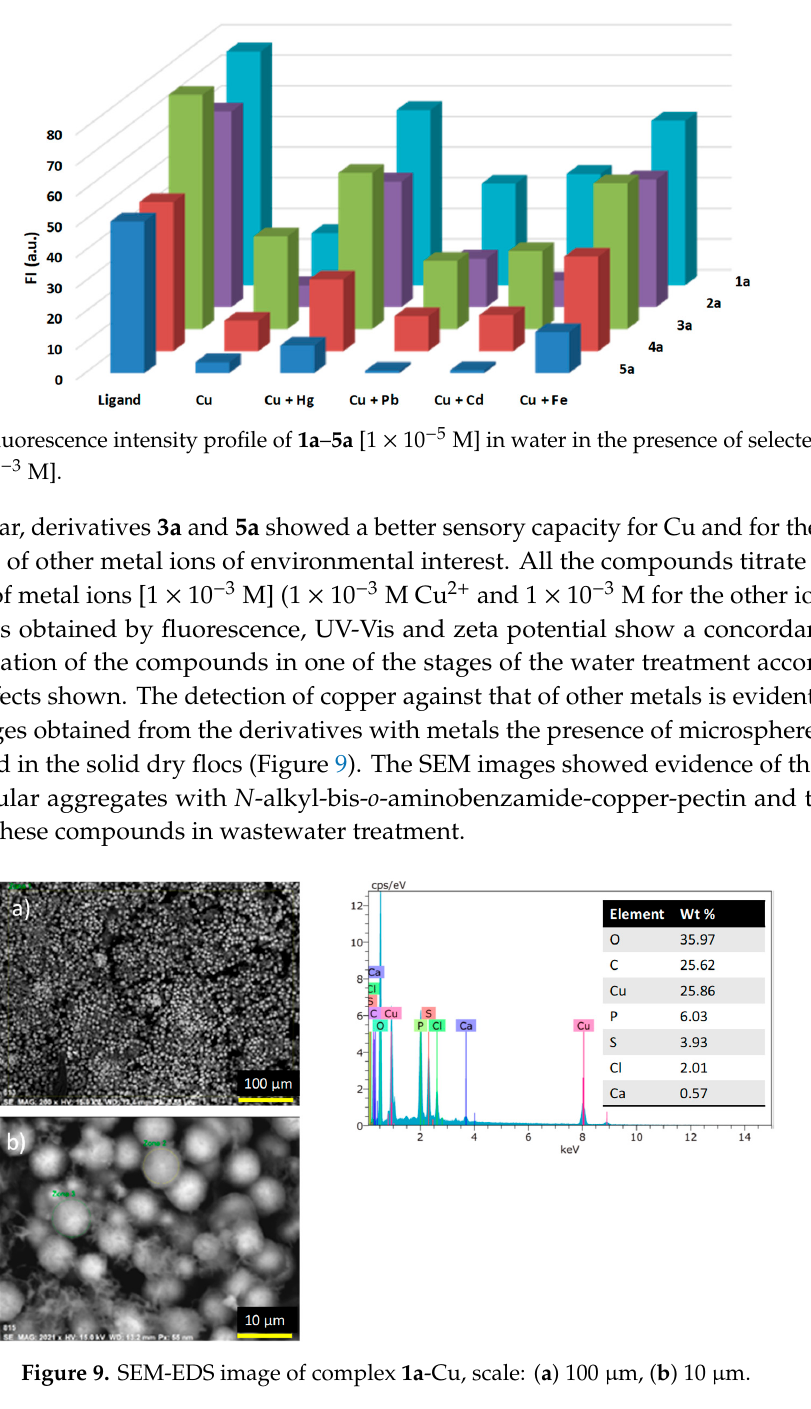
Figure 9. SEM-EDS image of complex 1a -Cu, scale: ( a ) 100 μ m, ( b ) 10 μ m.